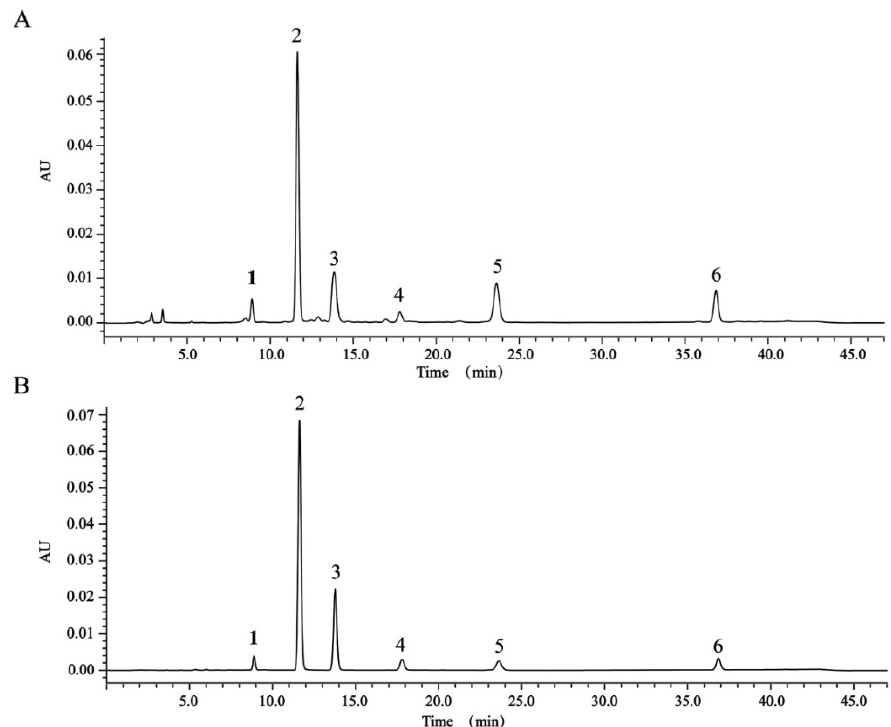
Figure 6. HPLC chromatograms of total diterpenoids from the root of Euphorbia ebracteolata Hayata (TDEE) ( A ) and six diterpenoid standards ( B ). Peak 1: euphorin G; peak 2: ent-11 α -hydroxyabicta- 8(14), 13(15)-dien-16, 12-olide; peak 3: jolkinolide B; peak 4: euphebracteolatin A; peak 5: fischeria A; peak 6: jolkinolide E.